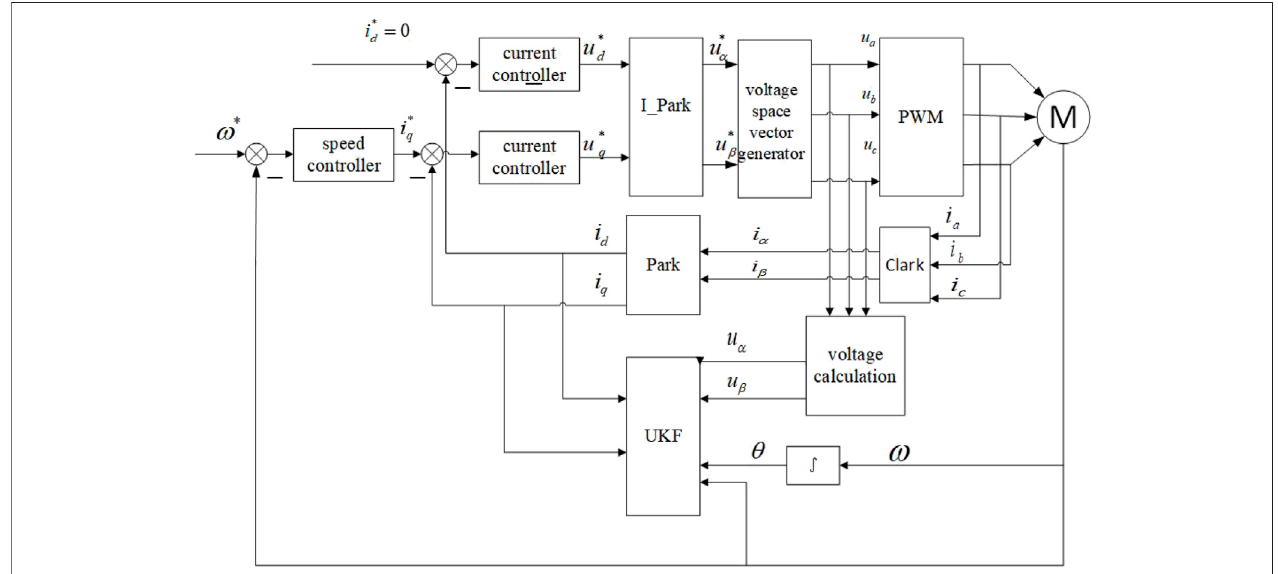
FIGURE 1 | Block diagram of the vector control scheme for PMSM without a position sensor with parameter identi fi cation.